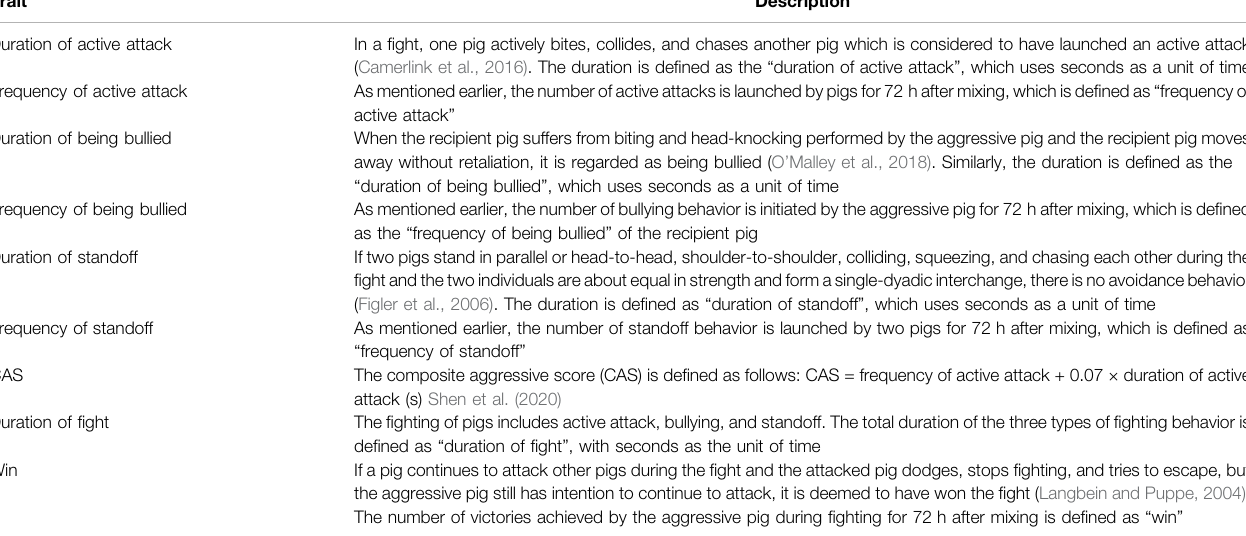
TABLE 1 | Description of indicators used to evaluate